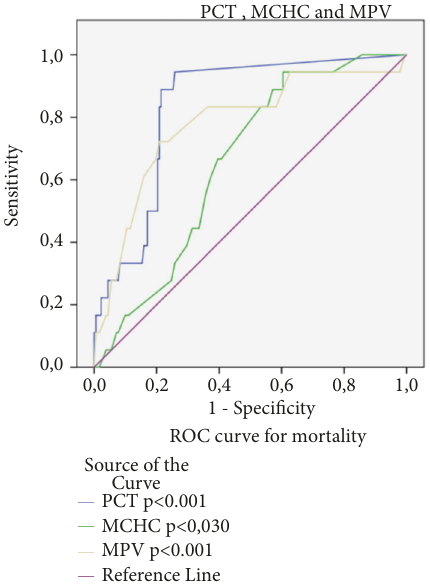
Figure 1: ROC curve analysis according to PCT, MCHC, and MPV mortality